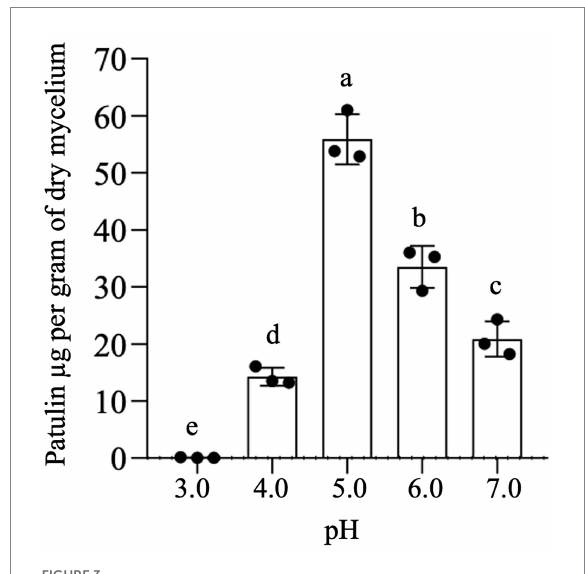
FIGURE 3 In vitro patulin production at fixed pH values. Patulin was extracted from a 7-day-old culture of Penicillium expansum strain 7015 in liquid AAM in which the pH was kept unvaried at fixed values. Data shown are the mean values ± SD from three independent experiments (black dots). Columns with common letters are not significantly different according to one-way ANOVA followed by uncorrected Fisher’s LSD comparison test ( p <